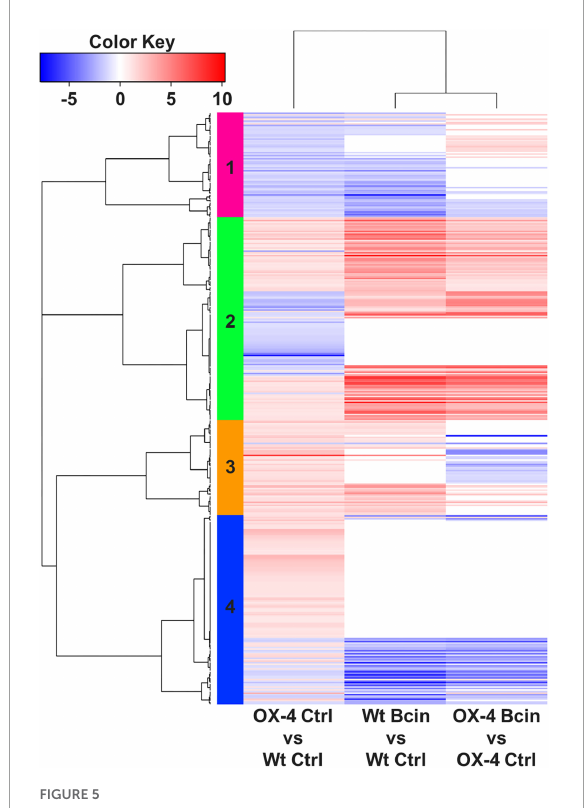
FIGURE5 Heatmap of hierarchical clustering of wild type and PpERF24-OX-4 overexpressing line during control treatment and B. cinerea infection. DEGs correspond to the 391 DEGs of PpERF24-OX-4 control vs. wild-type control plants. Selected DEGs had | log2 FC| ≥ 1 and FDR ≤ 0.05. See Supplementary Table 7 for complete